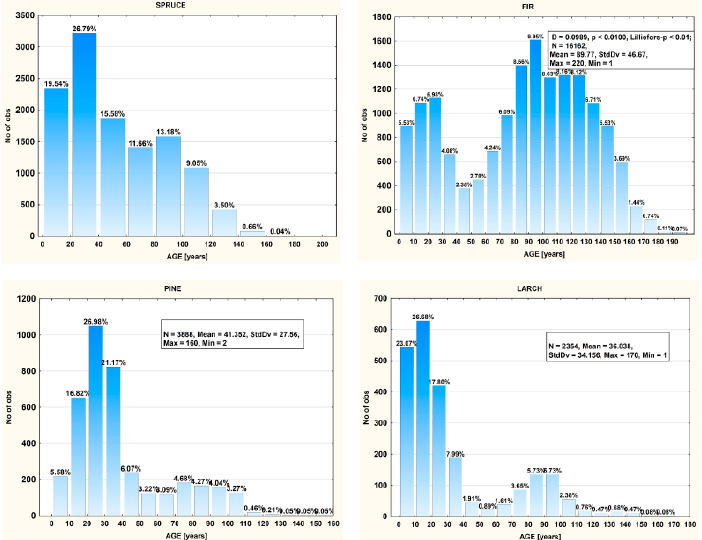
Figure 5. Distribution of stand elements based on age for resinous species located in Southern Car- pathians.